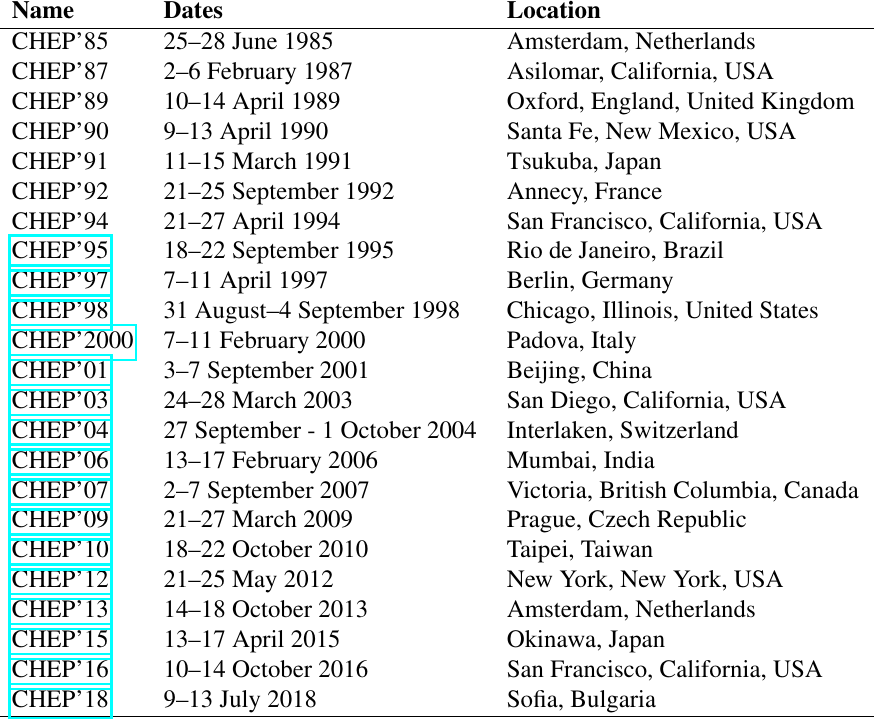
Table 1: Dates and locations of previous CHEP